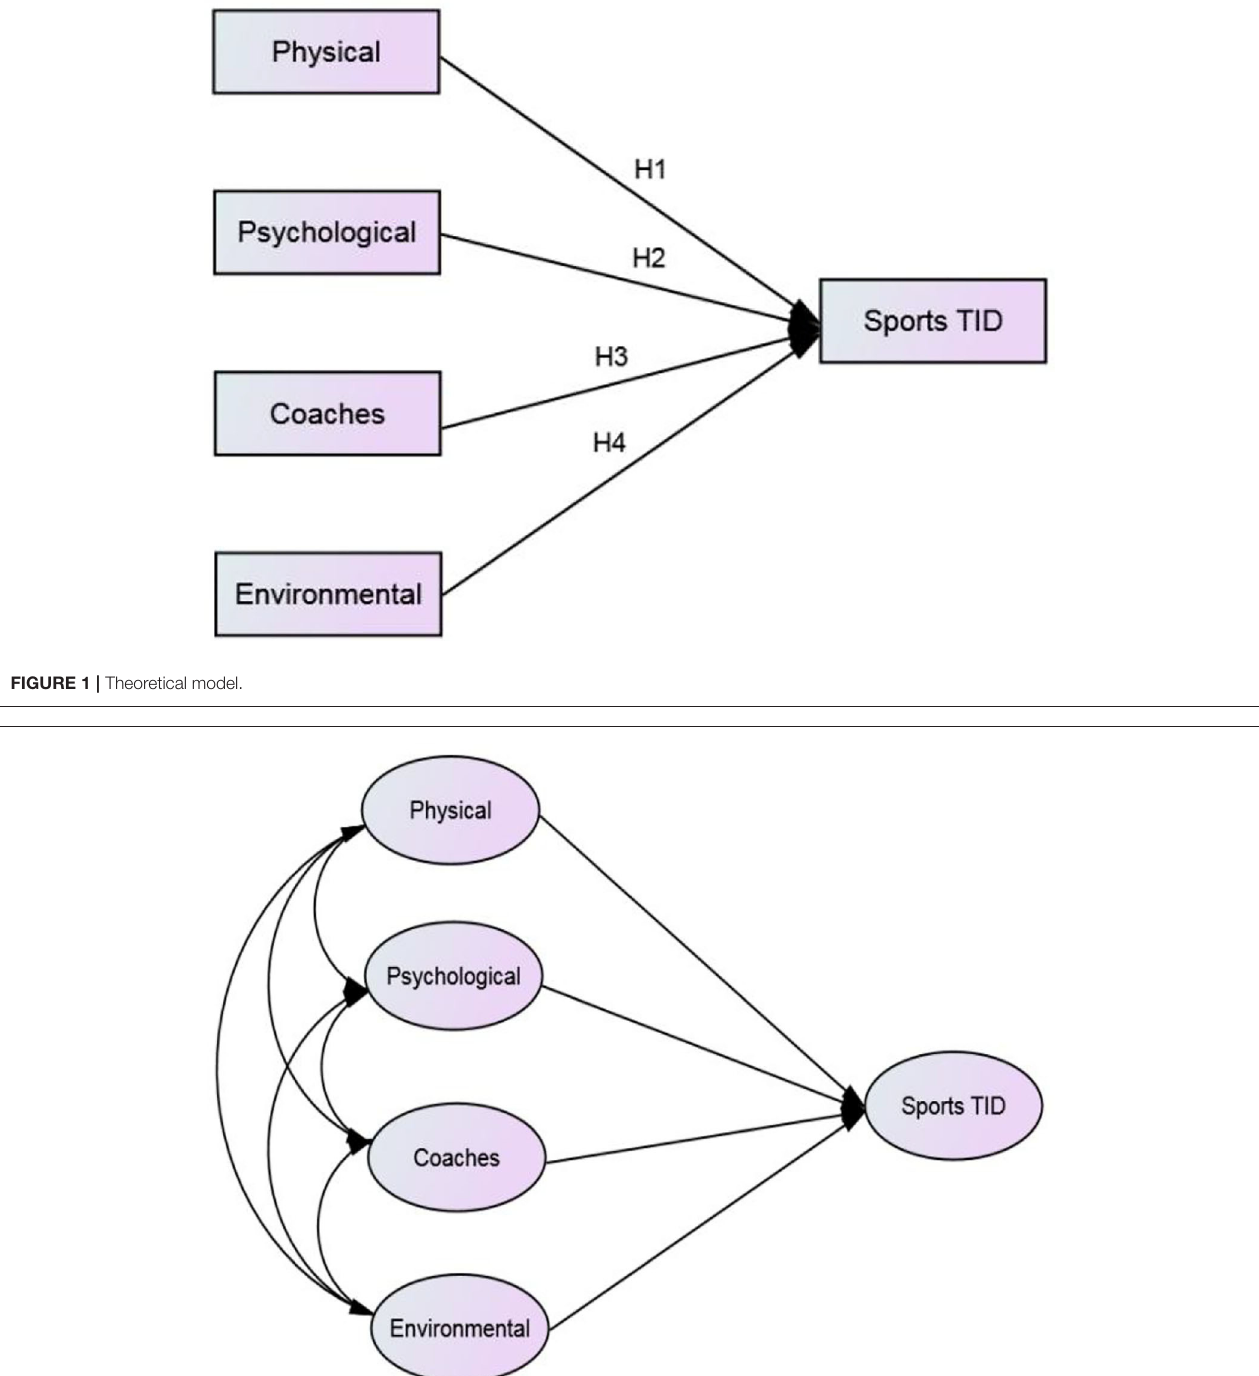
FIGURE 2 | Conceptual